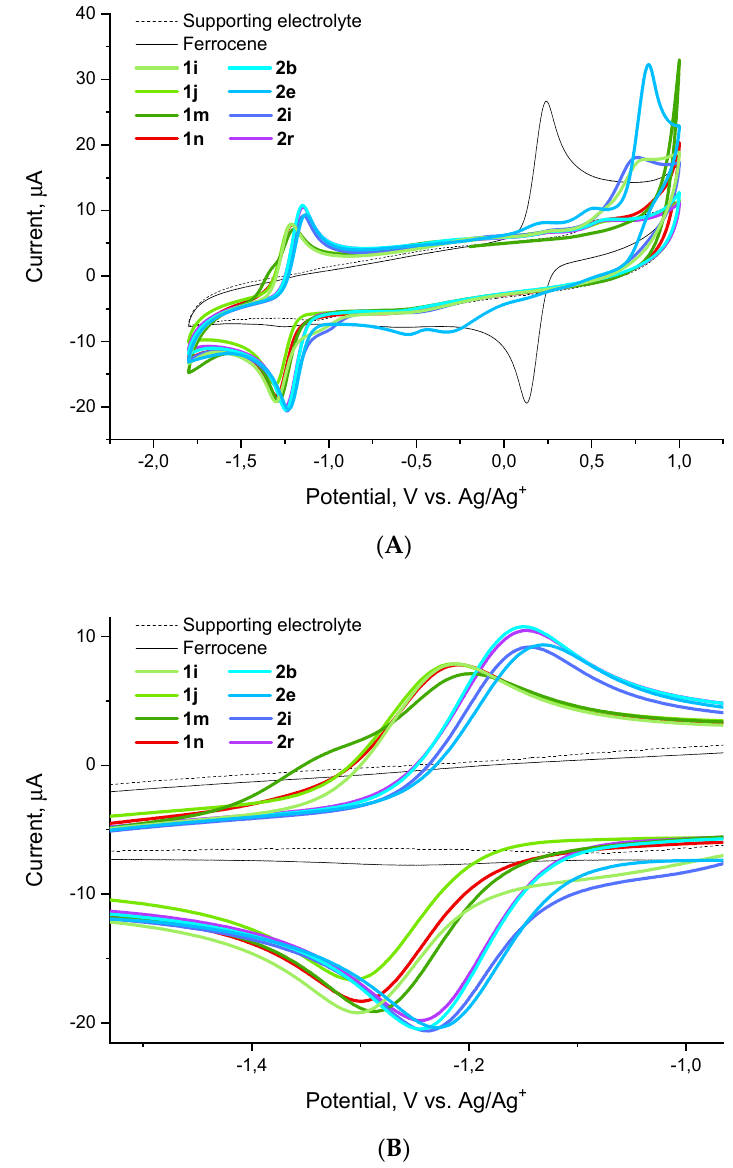
Figure 5. Cyclic voltammograms for compounds 1i , 1j , 1m , 1n , 2b , 2e , 2i and 2r obtained relative to the ferrocene standard: ( A ) full view, ( B ) redox wave close-up.